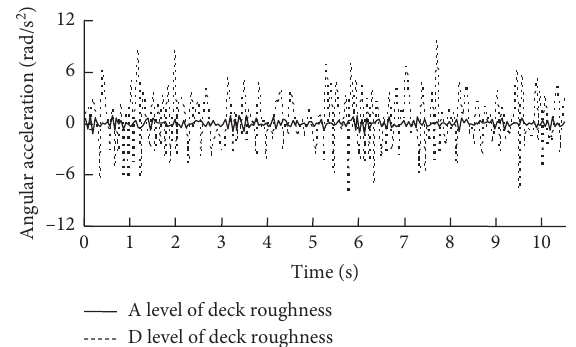
Figure 9: The time-history curves of pitching vibration accelera- tions of the vehicle body.